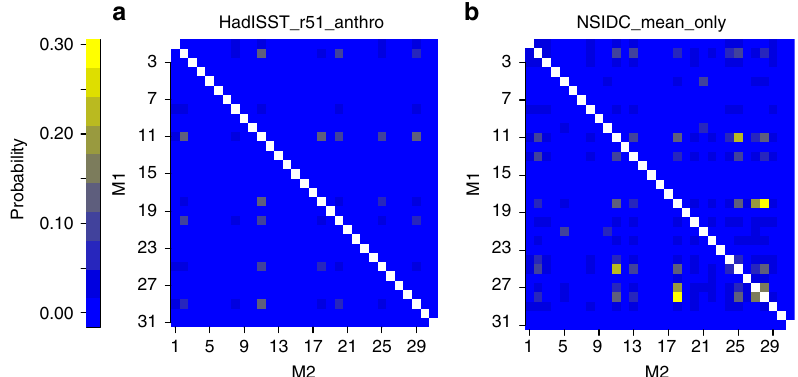
Fig. 2 Joint model probabilities. a HadISST_r51_anthro and b NSIDC_mean_only experiments. NSIDC_mean_only experiment does not consider sea ice sensitivity to global mean surface temperature. y - and x axes index the fi rst and the second climate model in the pair, while the joint probability is represented by color. The fi gure highlights the capability of the method to fi nd joint probability of any pair of hypotheses in the set. There are less instances of high pair weights once the second constraint of sea ice sensitivity is introduced in the HadISST_r51_anthro experiment. This suggests that using multiple constraints may reduce the impact of hypothesis